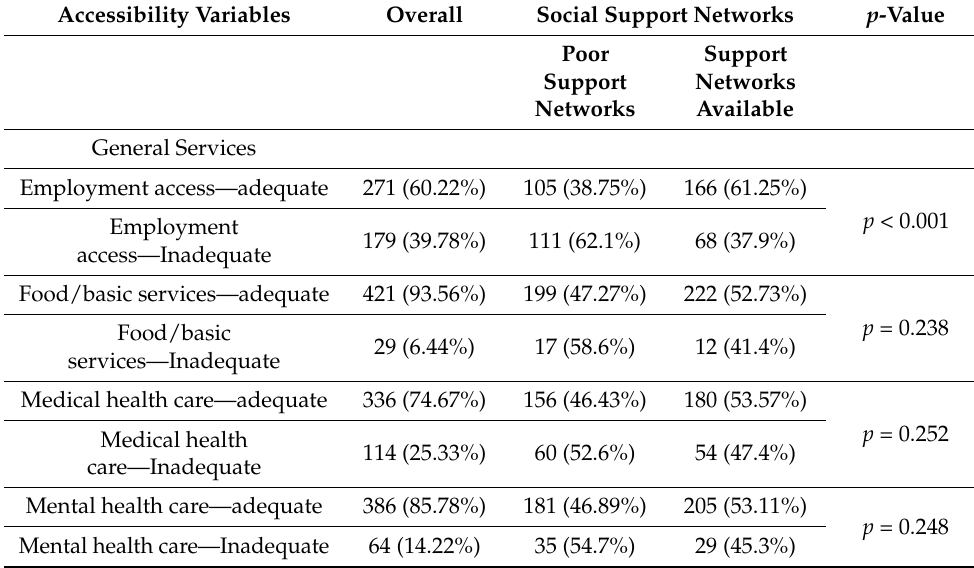
Table 3. Service accessibility and social support networks.